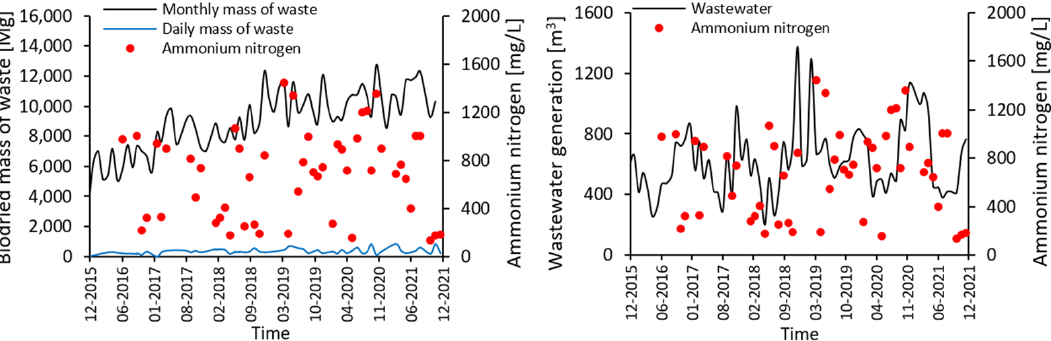
Figure 3. Characteristics of the basic physical parameters of industrial wastewater generated on the ZUOK site in Olsztyn between December 2015 and December 2021. The red line indicates the per- missible values as set out in the integrated permit.